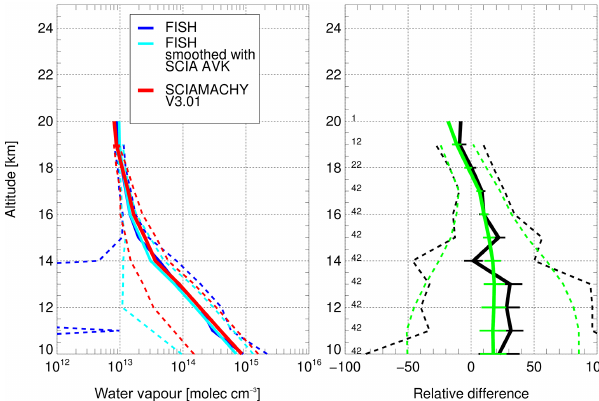
Figure 14. Left panel: mean profiles over all collocations from SCIAMACHY and FISH data (the two lines show the data interpo- lated on the retrieval grid of SCIAMACHY and smoothed with the AVK of SCIAMACHY, respectively) and their standard deviations (dashed line). Right panel: mean percentage difference between SCIAMACHY water vapour profiles and FISH profiles interpolated to the SCIAMACHY retrieval grid (black line) and smoothed with the AVK of SCIAMACHY (green line). The dotted lines show the standard deviation, the error bars (if visible) depict the standard er- ror of the mean. The number of collocations is given for each alti- tude.